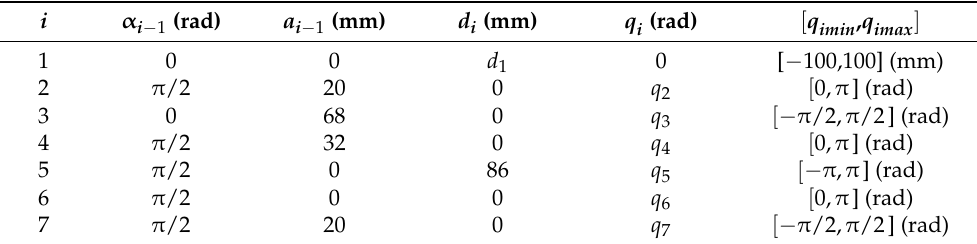
Table 1. Modified DH parameters and joint position limits of the 7-DOF